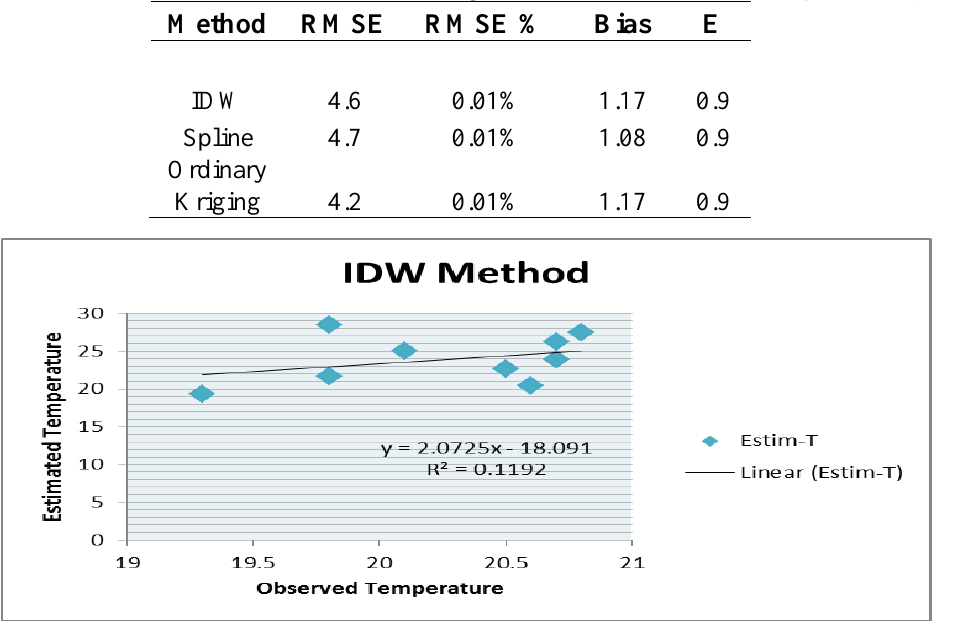
Table 2: Error statistics for 3 methods using climate data (maximum temperatures)